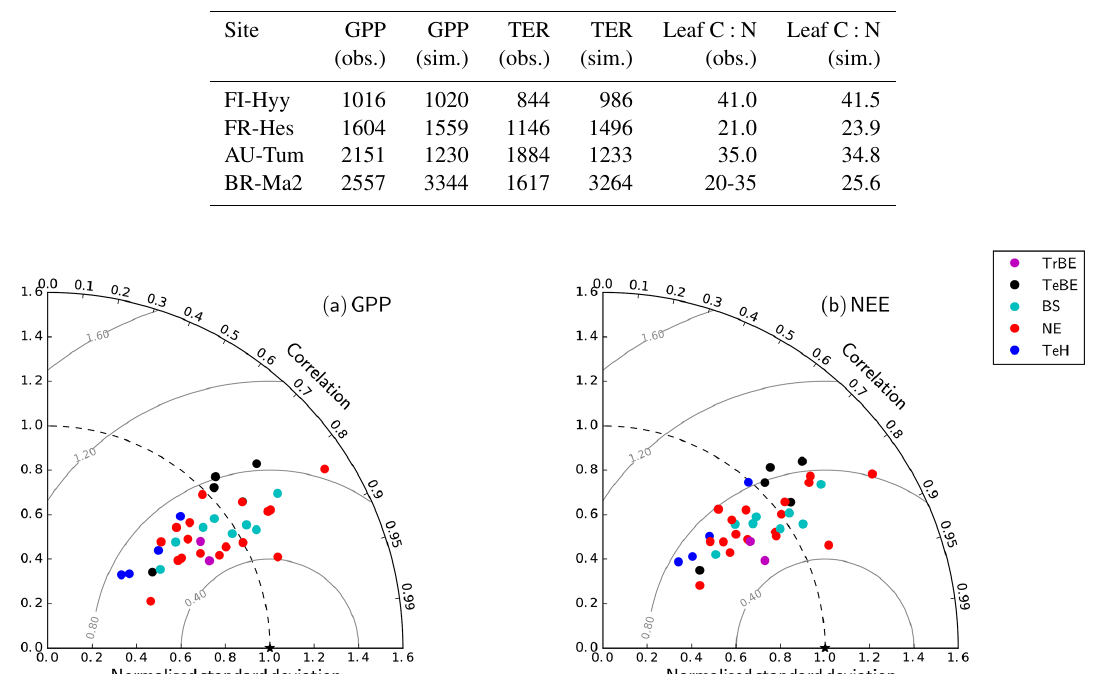
Figure 4. Taylor plots for GPP and net ecosystem exchange (NEE) showing the model–data agreement for the FLUXNET sites used in this study (Table A1), separated according to the dominant plant functional type (Table 1). The standard deviation was normalised against the standard deviation of the observations for the corresponding variable. The grey lines correspond to the Euclidean distance from the point of perfect model–data agreement, where both the normalised standard deviation and the correlation coefficient are 1.0, shown as a black star in the